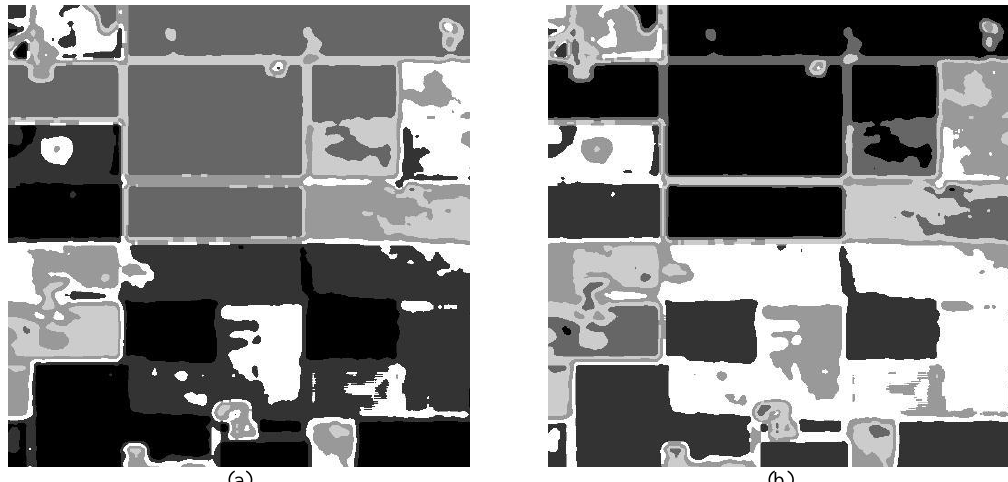
Figure 6. Result of segmentation. (a) FCM clustering with 11 × 11 windowsize (b) k-means clustering 11 × 11